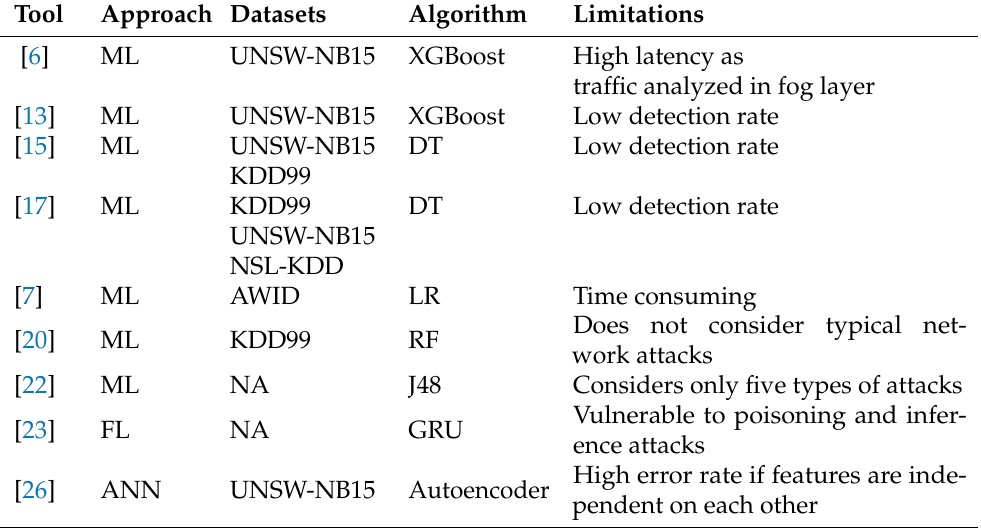
Table 2. Comparison of Existing